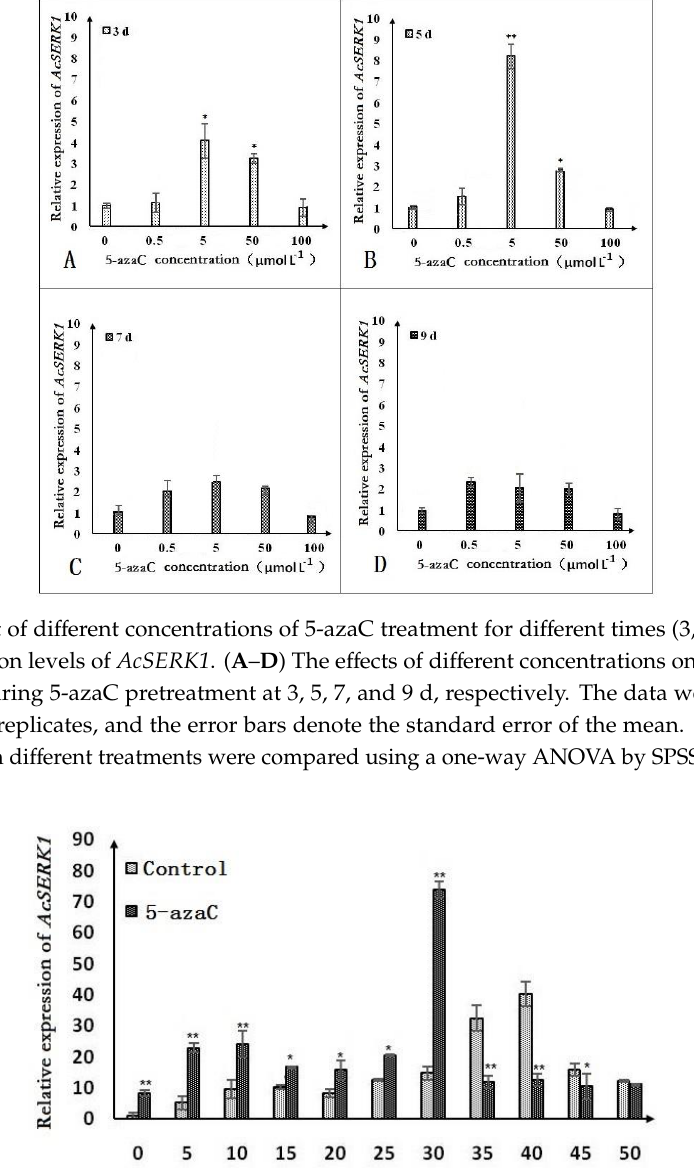
Figure 3. Effect of different concentrations of 5-azaC treatment for different times (3, 5, 7, or 9 days) on the expression levels of AcSERK1 . ( A – D ) The effects of different concentrations on the expression of AcSERK1 during 5-azaC pretreatment at 3, 5, 7, and 9 d, respectively. The data were the average of 3 biological replicates, and the error bars denote the standard error of the mean. The expression differences with different treatments were compared using a one-way ANOVA by SPSS 19.0. * p < 0.01 and ** p < 0.05.